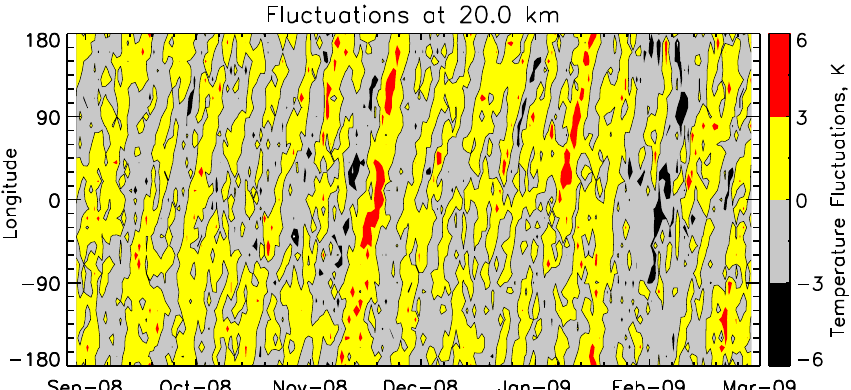
Fig. 3. Temperature fluctuations at 20km during the period of interest from September 2008 to February 2009. Observe the eastward propagating large scale structures.